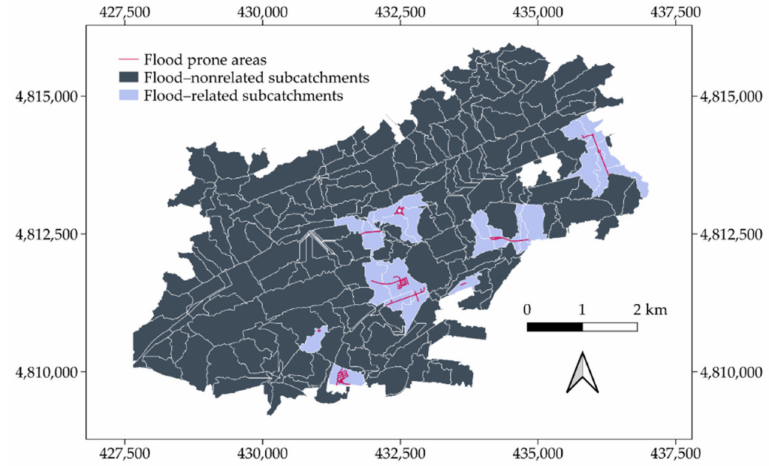
Figure 6. Overlap between the subcatchments delineated using ArcDrain and the flood prone areas highlighted by the City Council of Santander.